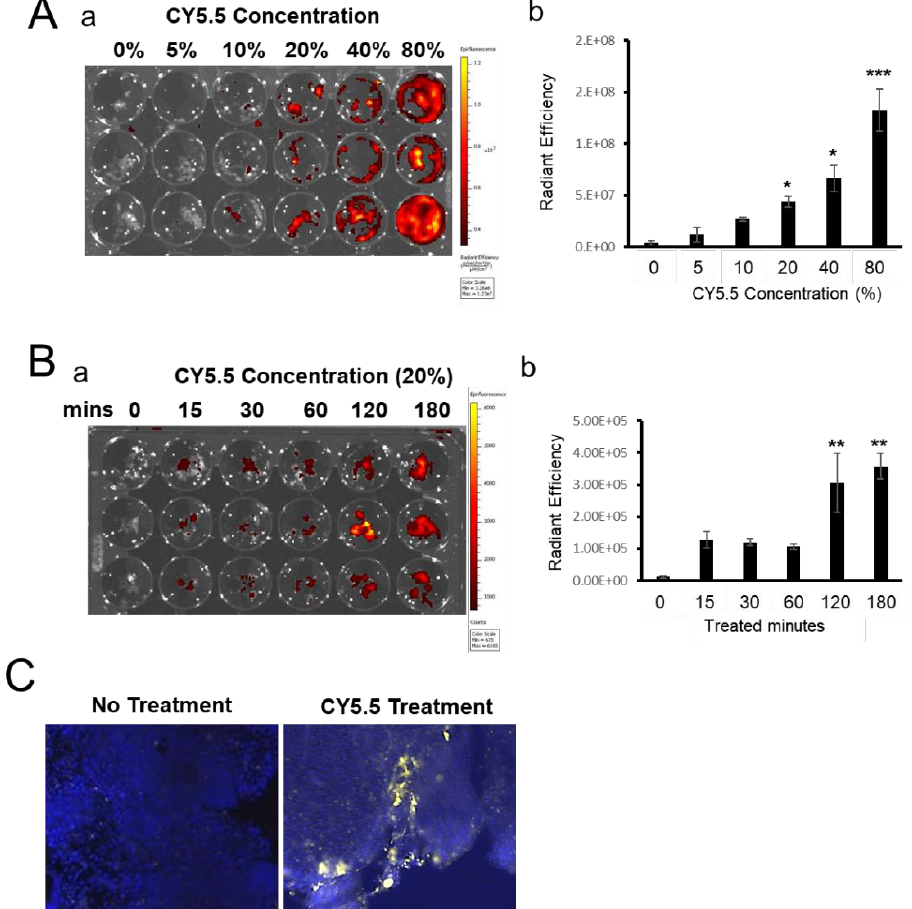
Figure 3. Optimization of ex vivo labeling condition with Cy5.5 dye-doped silica nanoparticles in uterine tissue fragments. ( A ) Representative images ( a ) and quantification ( b ) of Cy5.5 labeling at different concentrations of Cy5.5 dye-doped silica nanoparticles. Uterine tissue fragments were incubated with 0, 5, 10, 20, 40, 80% of Cy5.5 dye-doped silica nanoparticles for 3 h. The intensity of Cy5.5 was examined using IVIS spectrum. ( B ) Representative images ( a ) and quantification ( b ) of Cy5.5 labeling on different incubation times of Cy5.5 dye-doped silica nanoparticles. Uterine tissue fragments were incubated with 20% ( v / v ) Cy5.5 dye-doped silica nanoparticles for 0, 15, 30, 60, 120, 180 min. ( C ). Representative fluorescence images of Cy5.5 in uterine tissue without (a) and with (b) Cy5.5 dye-doped silica nanoparticles. Yellow fluorescent protein indicates Cy5.5 expression, and nuclei were counterstained with DAPI. Data are represented as mean ± SEM. * p < 0.05, ** p < 0.01, and *** p <